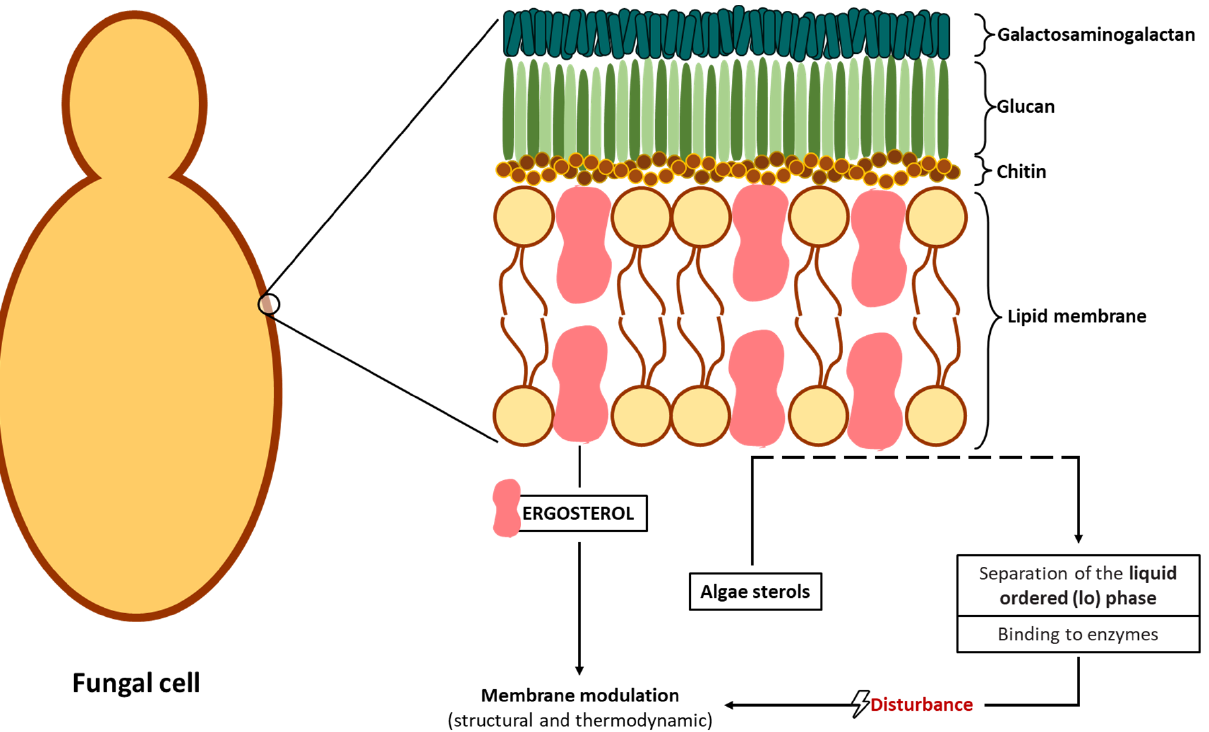
Figure 3. Schematic representation of a possible interaction of algae sterols in the fungal